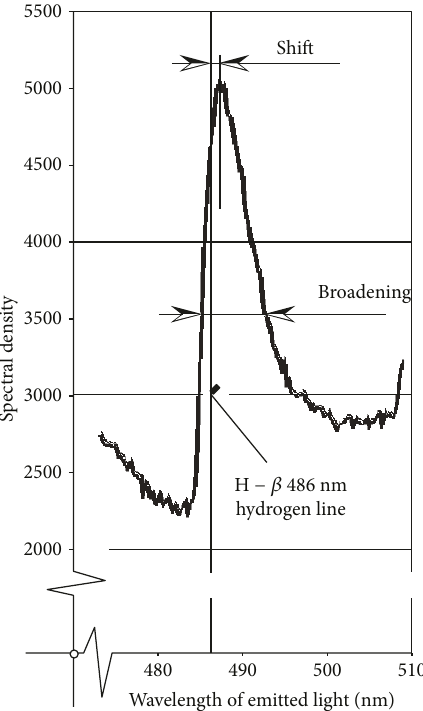
Figure 14: Typical example of spectroscopic measurement of combustion product temperature. Doppler e ff ect of elementary moving light sources causes broadening of the line which in principle makes it possible [16, 17] to evaluate the